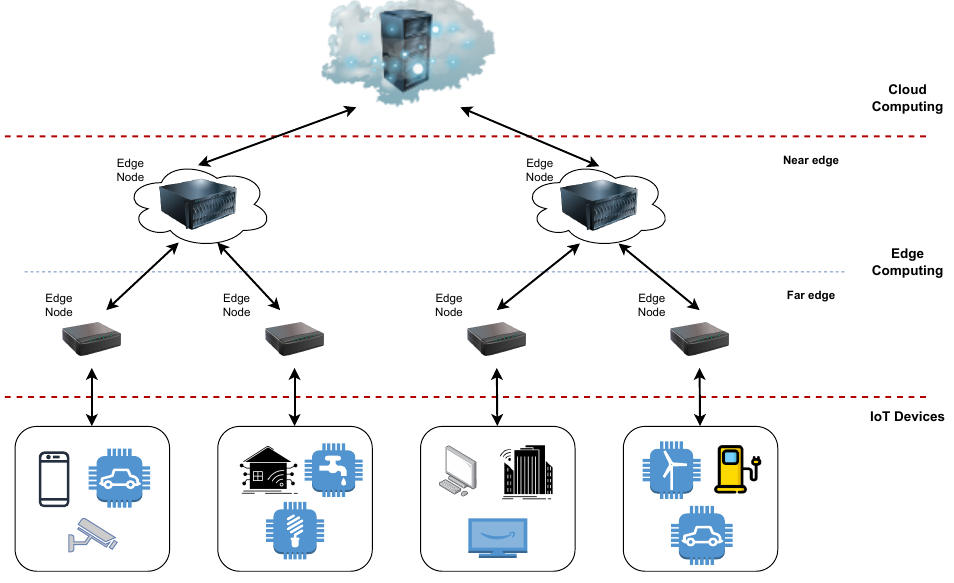
Figure 1. Abstract view of the Edge-to-Cloud